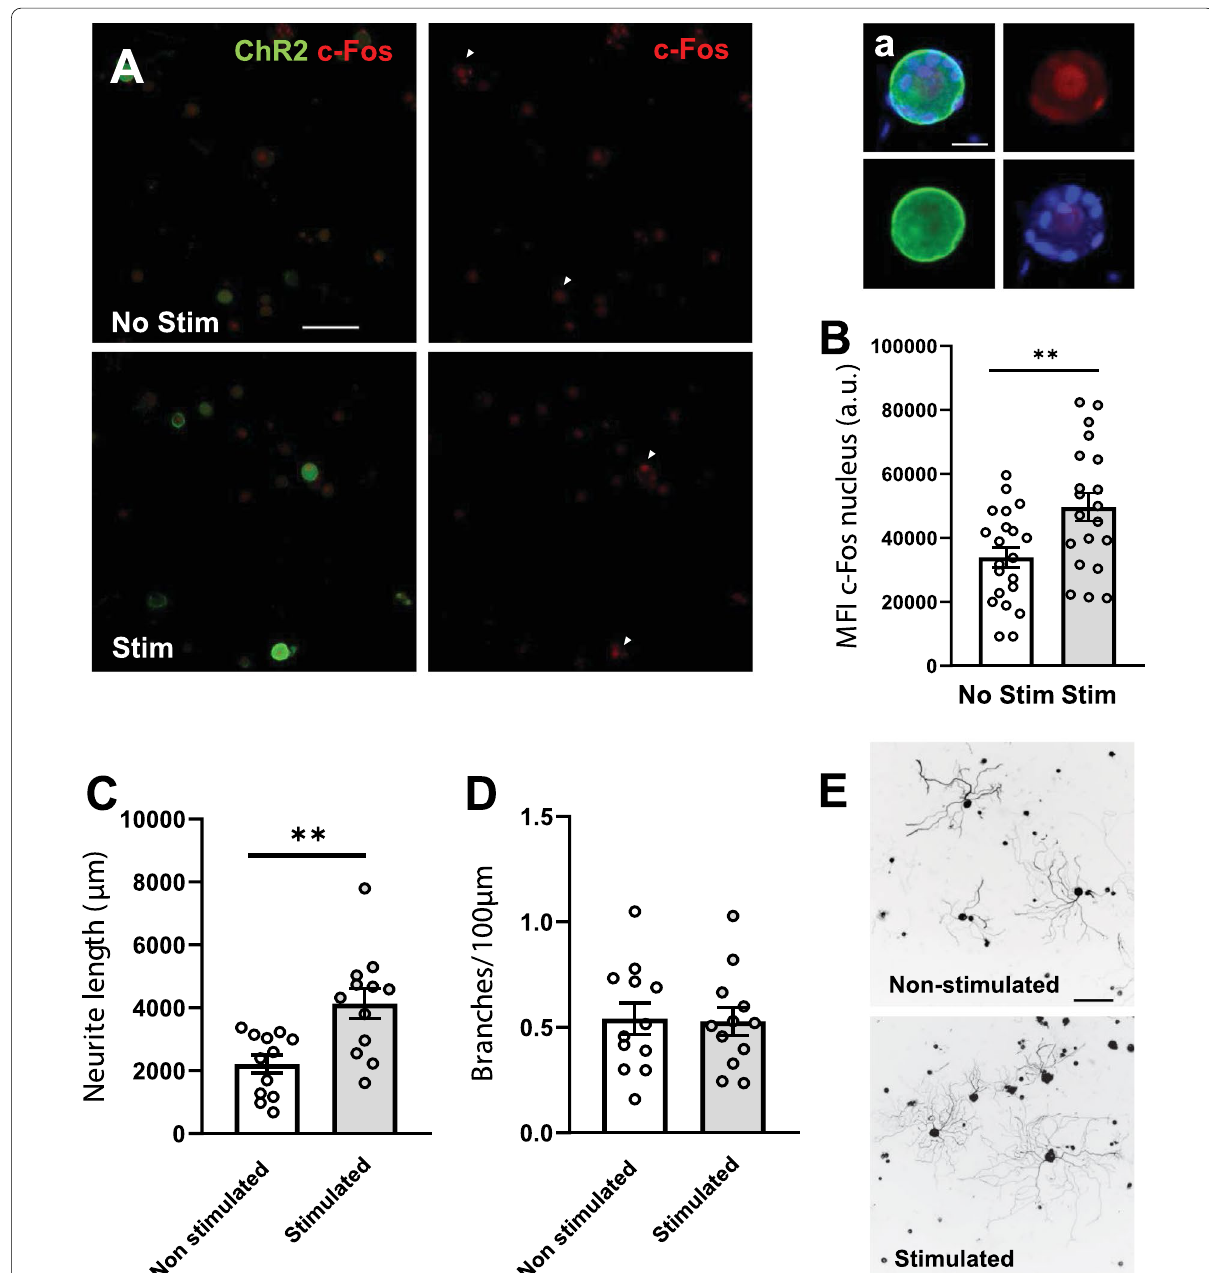
Fig. 1 Increased neuronal activity promotes neurite outgrowth. A Representative images of c‑Fos (red) and ChR2 (green) immunostaining. White arrows depict ChR2 + neurons. Scale bar: 100 μm. a. Higher magnification image of a stimulated neuron. ChR2 expression is mainly located in the membrane of large‑diameter neurons. Scale bar: 20 μm. B c‑Fos expression in the nucleus is increased just after optogenetic stimulation of Thy1‑ChR2 DRG neurons (n 20–25 cells). MFI: mean fluorescence intensity. a.u.: arbitrary units. Data are expressed as mean nuclear fluorescence = intensity s.e.m. **p < 0.01 denotes significant differences in Student’s t‑Test. C Stimulated neurons presented significantly higher neurite ± lengths when compared to non‑stimulated ones. Average neurite length per neuron was determined at 24 h in vitro. Data are expressed as mean s.e.m. (n 12 images; **p < 0.01 denotes significant differences in Student’s t‑Test). D Stimulation did not significantly modify the neurite ± = branching. Average number of branches for each 100 µm was determined at 24 h in vitro. Data are expressed as mean Representative images of Tuj‑1 staining used to analyze neurite length. Scale bar: 200